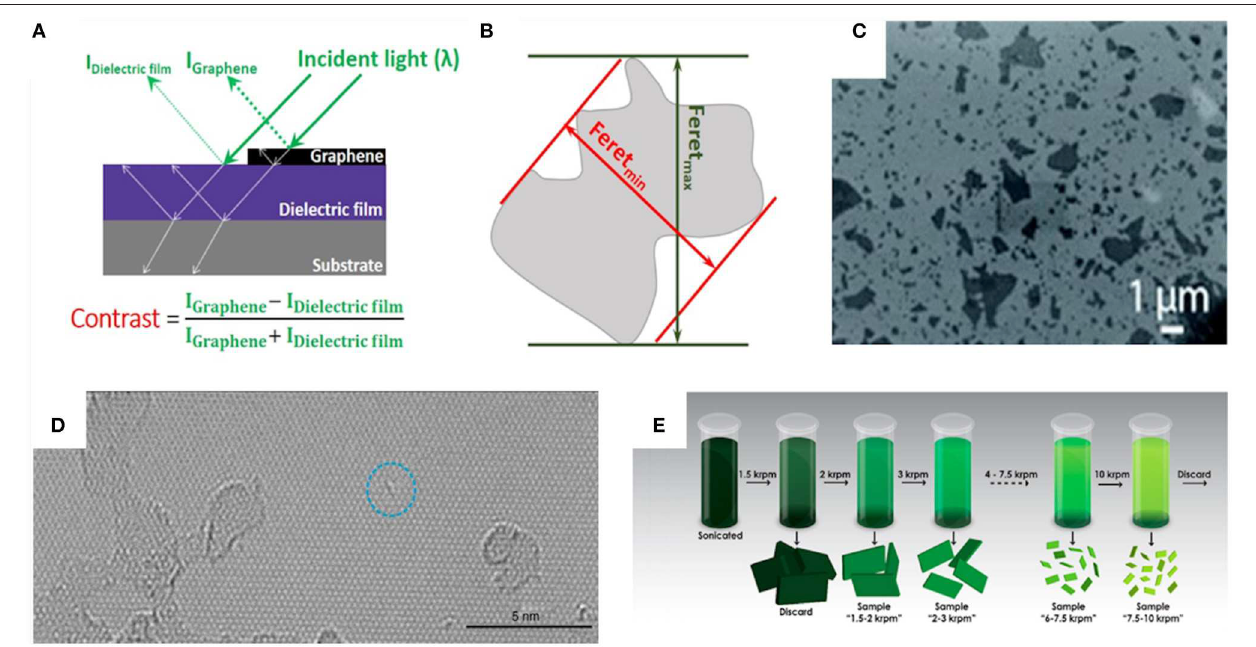
FIGURE 1 | (A) A schematic illustration of the image generation of a layered graphene system using light microscopy due to optical transmission and reflection. (B) A schematic explanation of Feret min and Feret max diameters. (C) The SEM images of graphene oxide with high optical contrast and flake overlapping. (D) A TEM image of honeycomb carbon lattice next to lattice defects. (E) The centrifugation cascade of exfoliated graphene to reach a narrow graphene flake size distribution. (A) Adapted with permission from Tan et al. (2017). Copyright (2017) American Chemical Society. (C) Reproduced under a Creative Commons Attribution (CC BY 3.0) license from Gao (2017). (D) Reproduced under a Creative Commons Attribution (CC BY 4.0) license from Seiler et al. (2018). (E) Reprinted with permission from Backes et al. (2016b). Copyright (2016) American Chemical